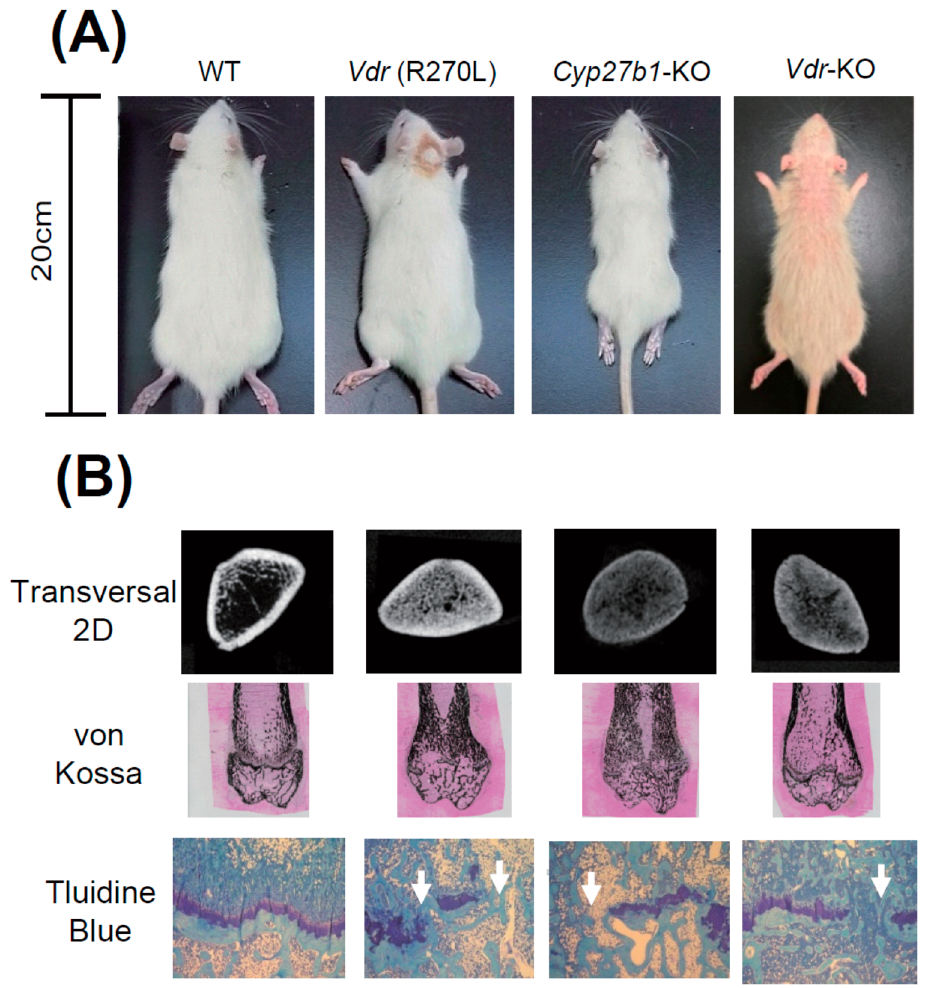
Figure 5. The appearance of GM rats and their abnormal bone formation [25]. (A) Comparison of body size and skin phenotype at 15 weeks of age. (B) First panels, 2D µ -CT images of horizontal section at distal femur; second panels, von Kossa staining of distal femur; bottom panels, toluidine blue staining of epiphyseal cartilage.